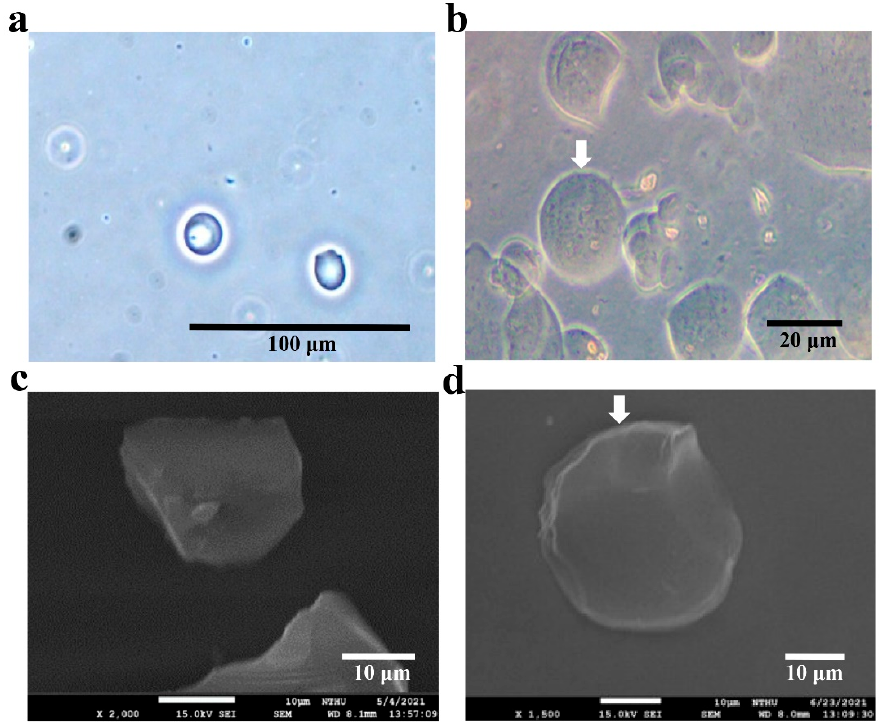
Figure 3. Optical microscopy ( a , b ) and scanning electron microscopy ( c , d ) of MPs. ( a , c ) Elec- trosprayed alginate MPs loaded with BSA. ( b , d ) BSA-loaded alginate MPs coated with chitosan. Scanning electron microscopy of ( c ) BSA/ALG/MPs with magnification 2000×; ( d ) BSA/ALG/CHI MPs with magnification 1500×; white scale bar: 10 µm. The white arrows indicate visible layers on the surface of alginate MPs.